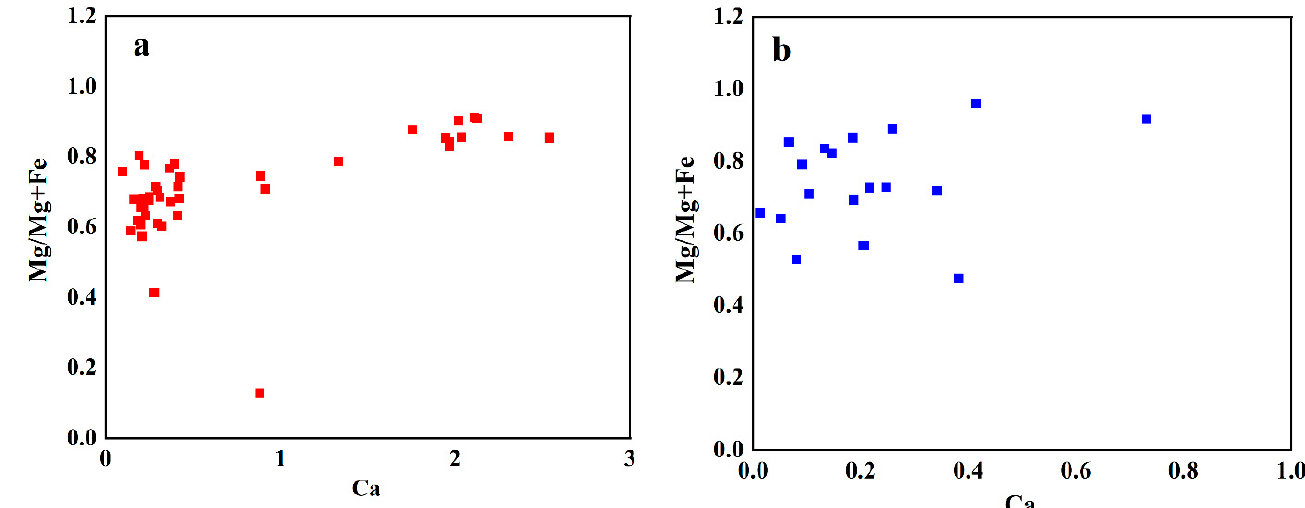
Figure 1. Discriminant diagram of Ca-Mg/(Mg + Fe) in Guatemalan and Qing dynasty jadeite. ( a ) Discriminant diagram of Guatemalan jadeite; ( b ) discriminant diagram of Qing dynasty jadeite. Each element is represented by an apfu value. apfu: Atoms per formula unit.